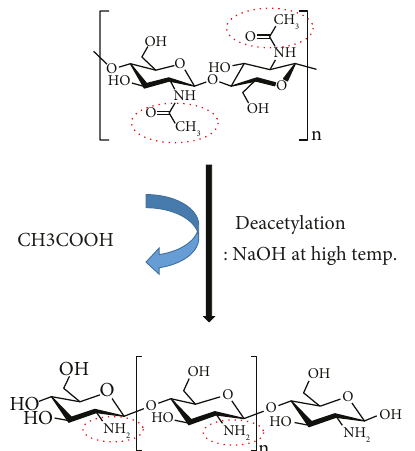
Figure 1: Schematic presentation of chitin deacetylation with